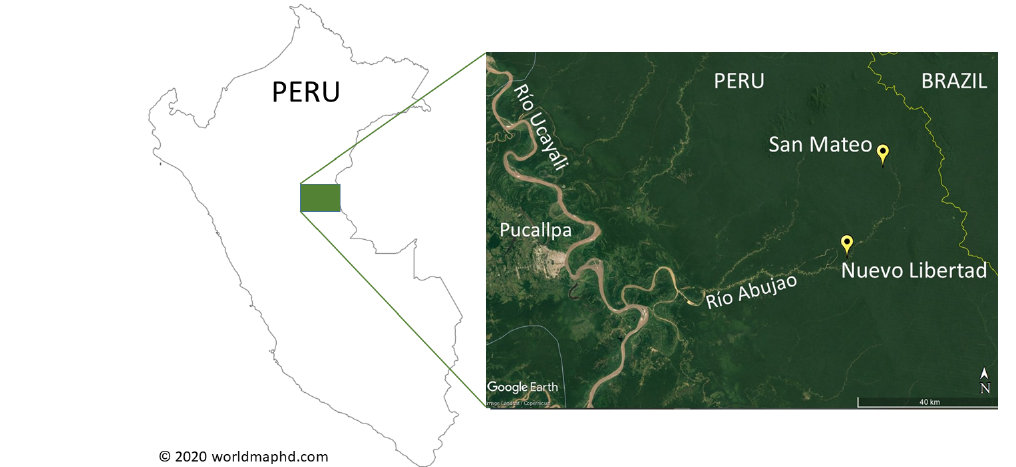
Figure 1. Location of the survey areas in Peru. Country map © World Map HD 2020 (https://www.worldmaphd.com/, last access: 30 May 2022); satellite image © Google Earth